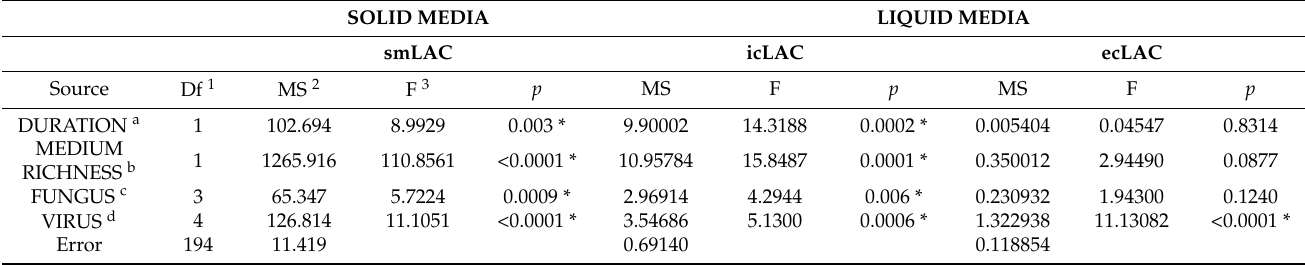
Table 2. Main effects ANOVA of laccase activity of Cryphonectria parasitica isolates infected with different Cryphonectria hypovirus 1 strains or uninfected controls, when grown on different growth media for 5 or 10 days. Statistically significant differences at p < 0.05 are denoted by an asterisk